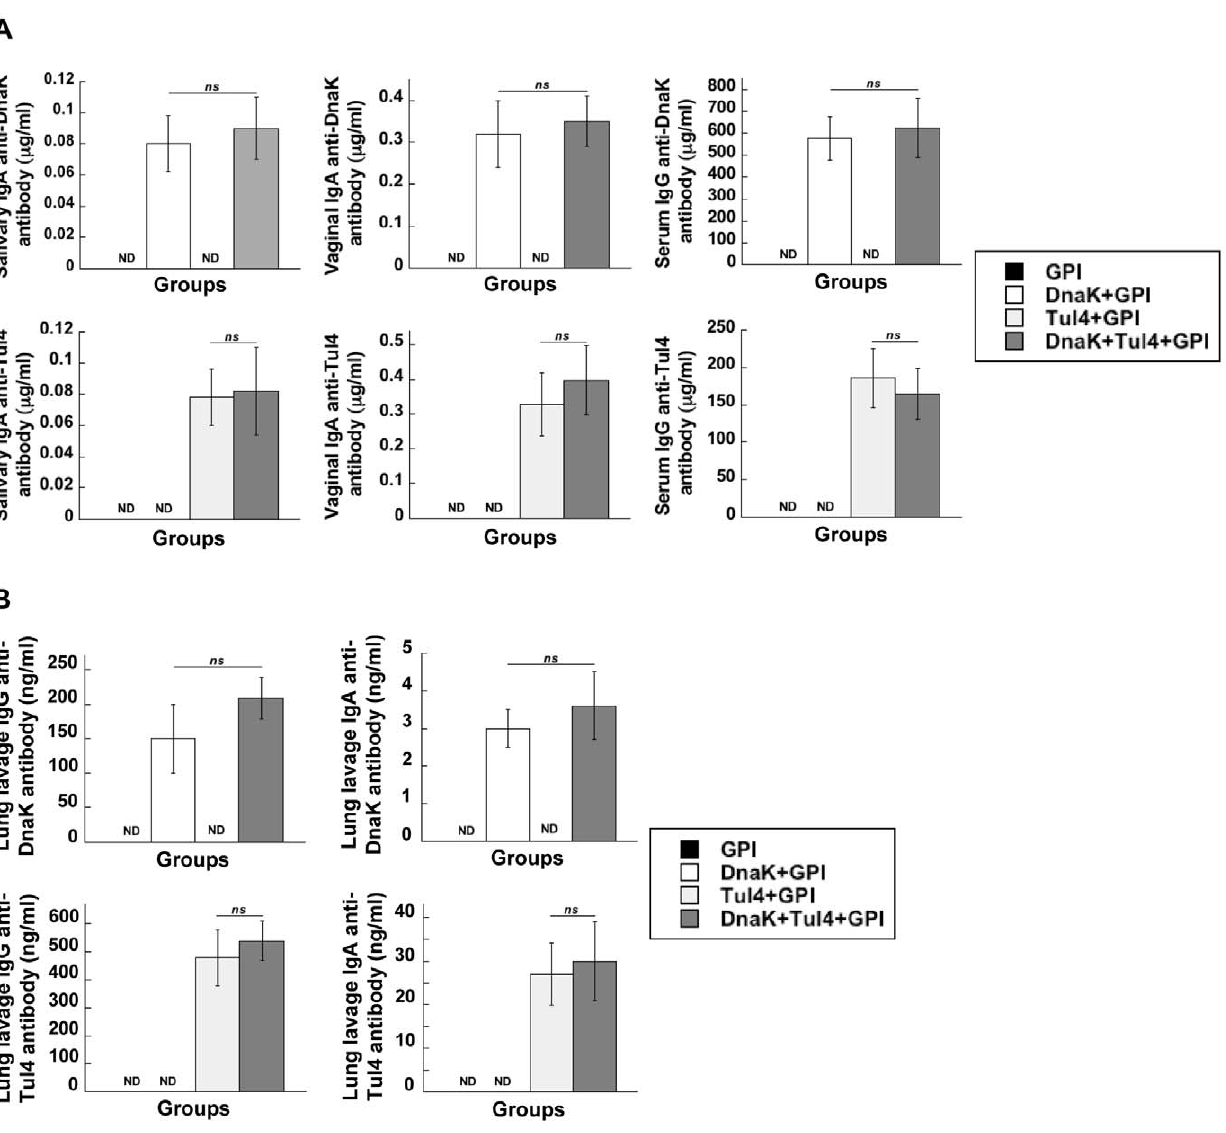
Figure 4. Induction of equivalent DnaK- and Tul4-specific mucosal and serum antibody responses following i.n. immunization with DnaK + Tul4 + GPI. Mice were immunized via the i.n. route with DnaK + GPI, Tul4 + GPI or DnaK + Tul4 + GPI on days 0, 14 and 28. (A) Individual saliva, vaginal wash and serum samples were collected 2 weeks following the last immunization. The levels of DnaK- and Tul4-specific IgA in the saliva and vaginal wash samples and IgG in the serum were determined by ELISA. (B) Individual bronchoalveolar lung lavage samples were collected 2 weeks following the last immunization and the levels of DnaK- and Tul4-specific IgA and IgG were determined by ELISA. There were 4 mice per experimental group and values are expressed as the mean 6 SEM. None detected (ND), not significant ( ns